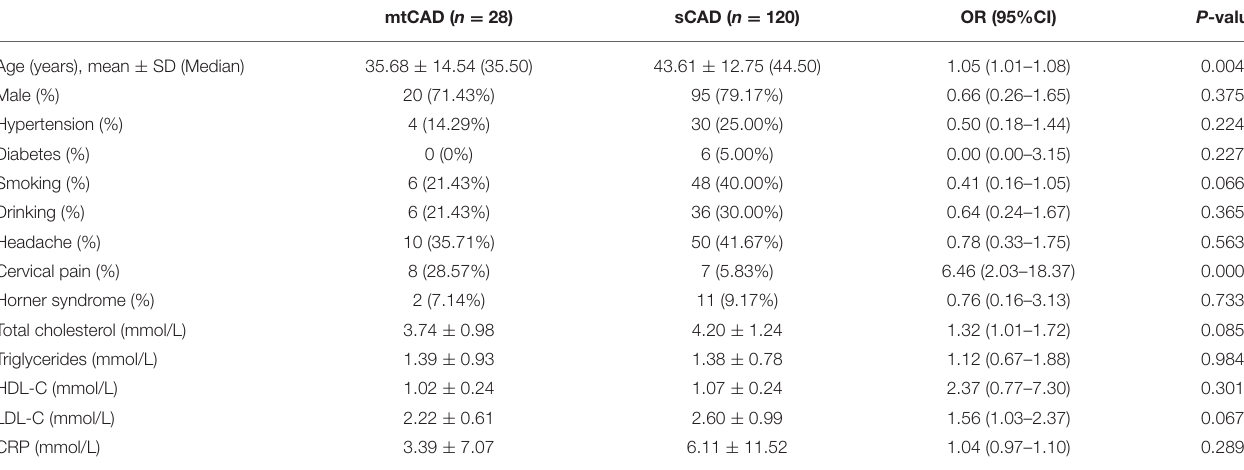
TABLE 1 | Demographic data and clinical features.